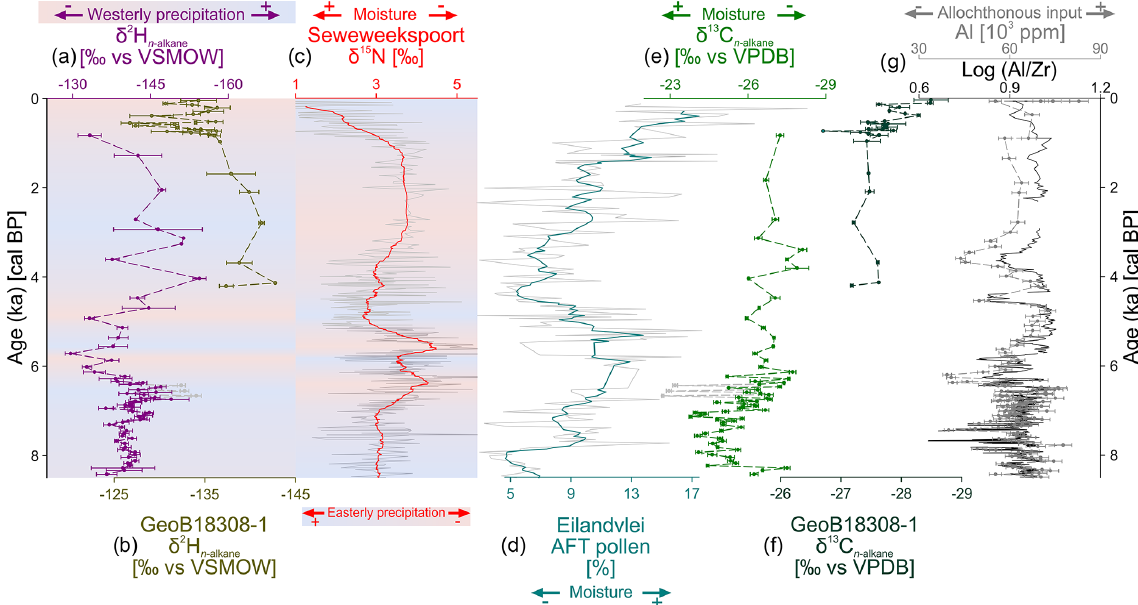
Figure 7. (a) δ 2 H n -alkane from Voëlvlei compared to (b) δ 2 H n -alkane from GeoB18308-1 (Hahn et al., 2017), (c) δ 15 N from Seweweek- spoort (Chase et al., 2017), (d) Afrotemperate forest pollen (AFT) from Eilandvlei (Quick et al., 2018), (e) δ 13 C n -alkane from Voëlvlei, (f) δ 13 C n -alkane from GeoB18308-1 (Hahn et al., 2017), and (g) aluminium (Al) content and Log Al / Zr ratio from Voëlvlei. The locations of the studies are depicted in Fig.